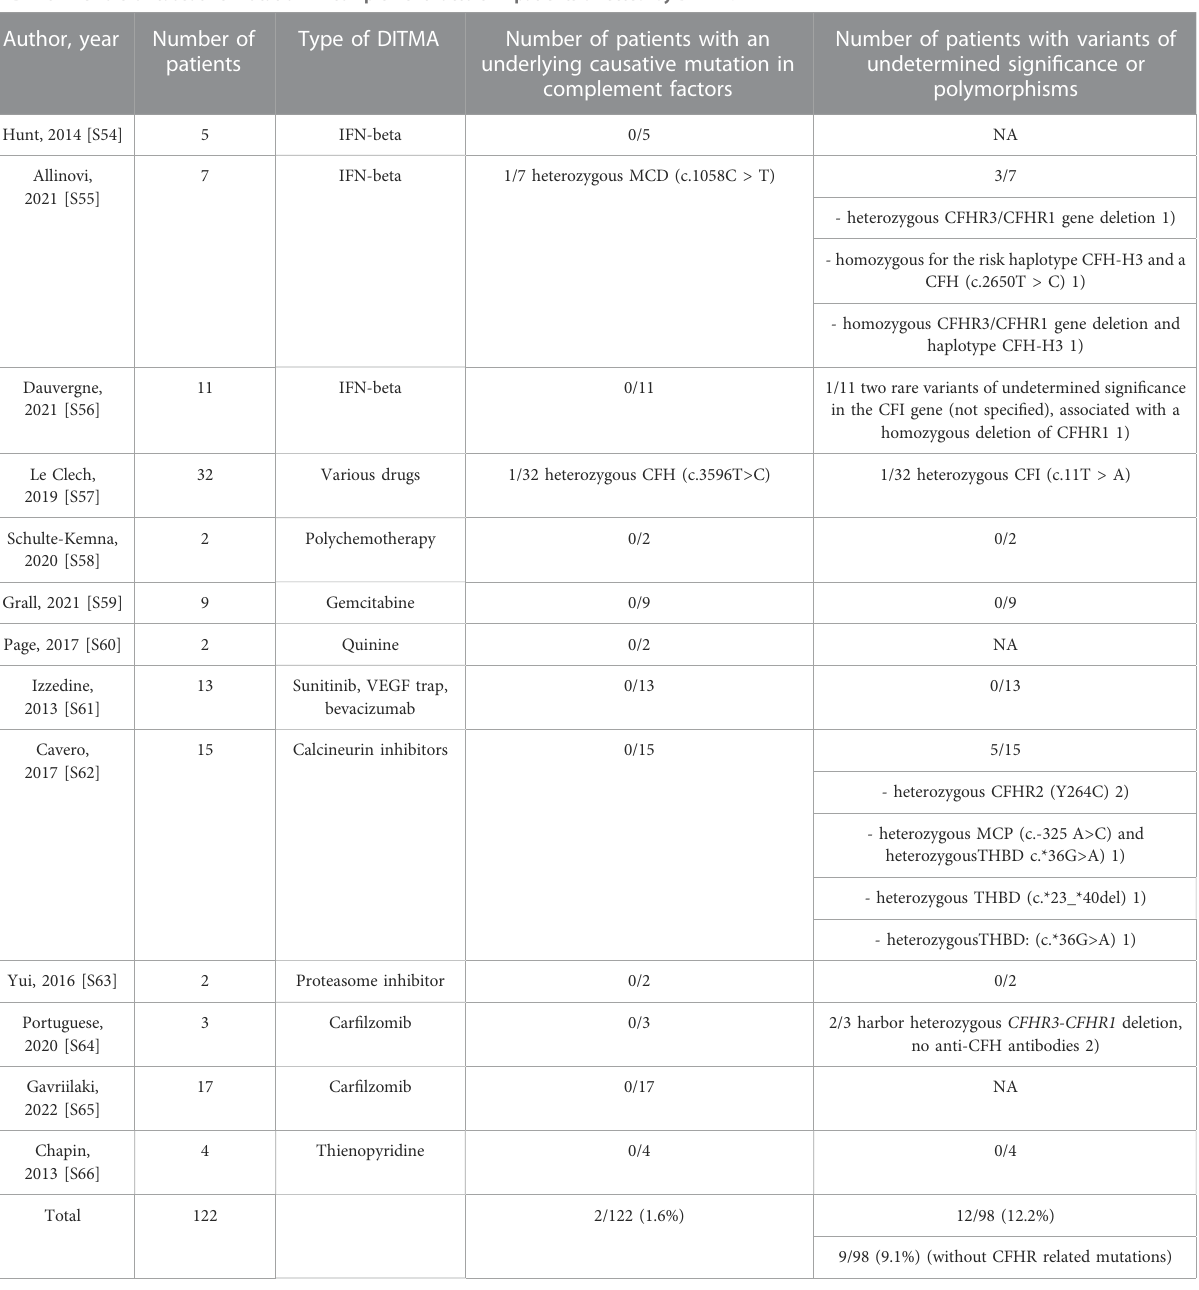
TABLE 3 The role of causative mutation in complement factors in patients affected by DITMA. Author,